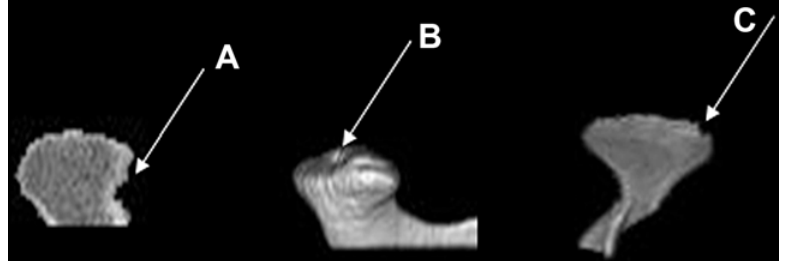
FIGURE 3 - MPR (A), 3DR-SSD and 3DR-MIP images showing erosion in the same mandibular